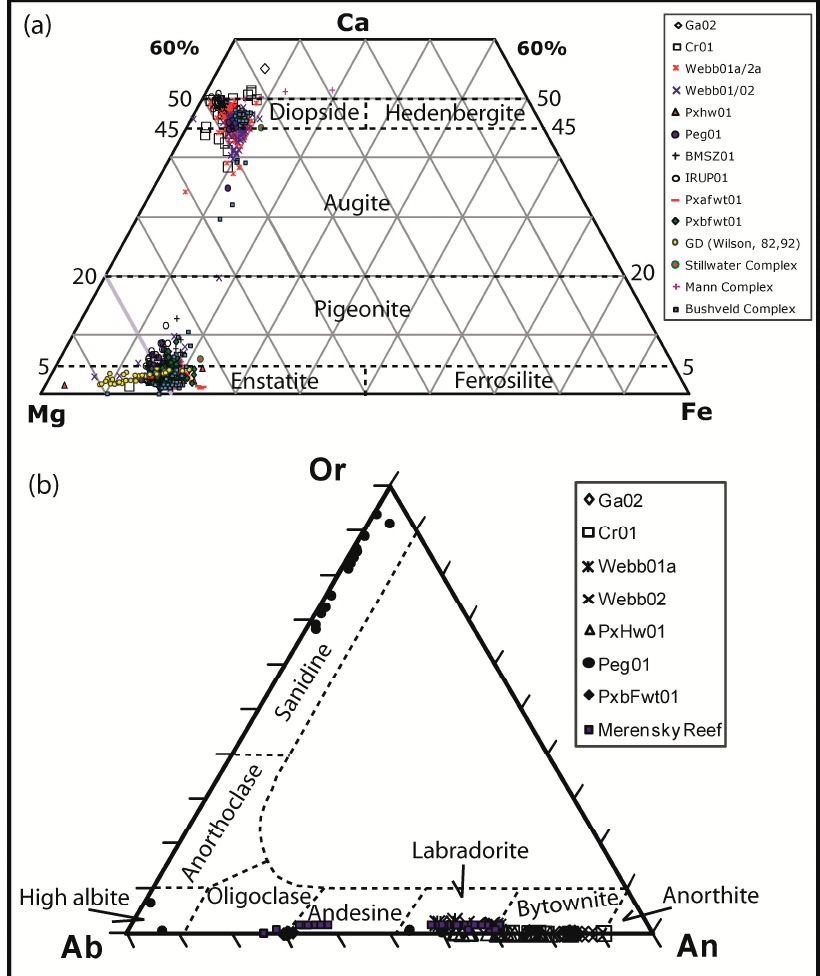
Figure 17. ( a ) Plot of pyroxenes from the present investigation compared to orthopyroxenes from